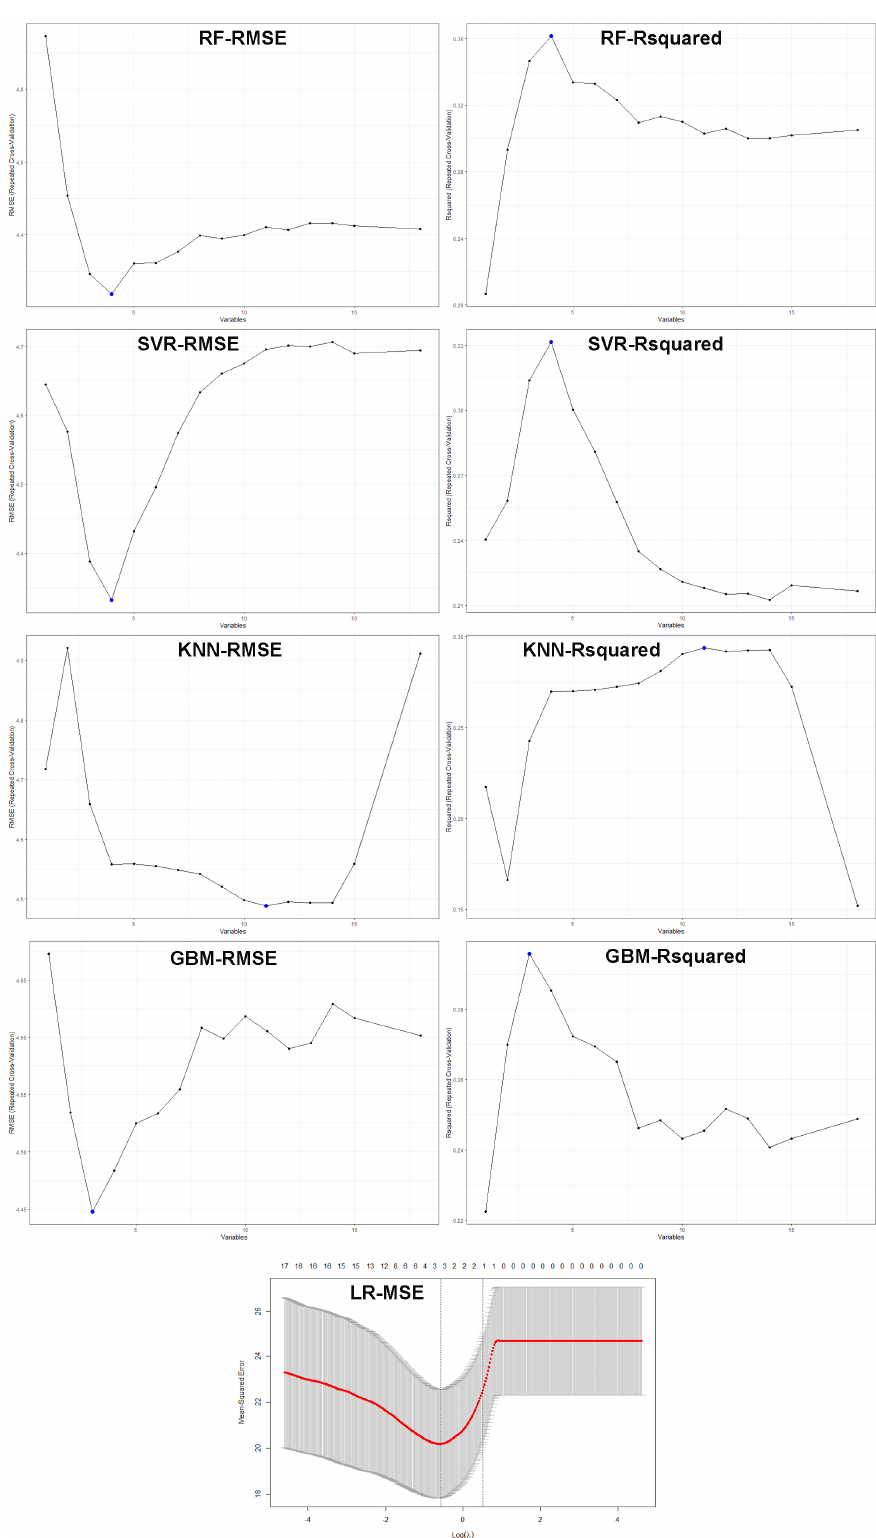
Figure A1. Plots of the results based on the RMSE used in the covariate selection during the recursive feature elimination (rfe) process.